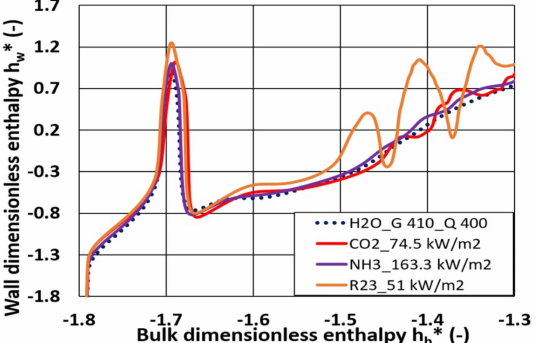
Figure 10. Predictions with the best heat fluxes for Watts’ data (Reference Case: G = 410 kg/m 2 s).